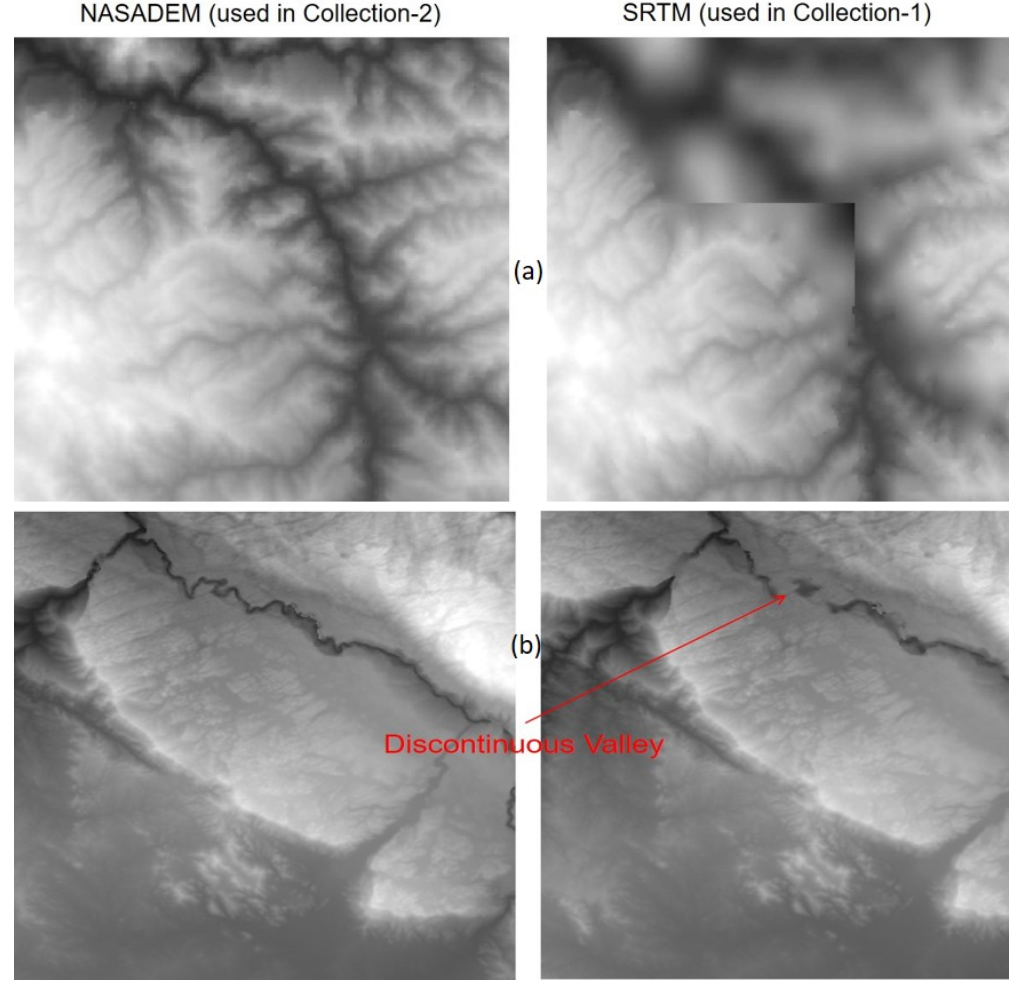
Figure 13. Artifacts in SRTM data found by visual assessment: ( a ) washout, ( b ) missing data. Table 8. Artifacts found in SRTM data using slope analysis algorithm, per region. Number of Tiles Analyzed Artifacts